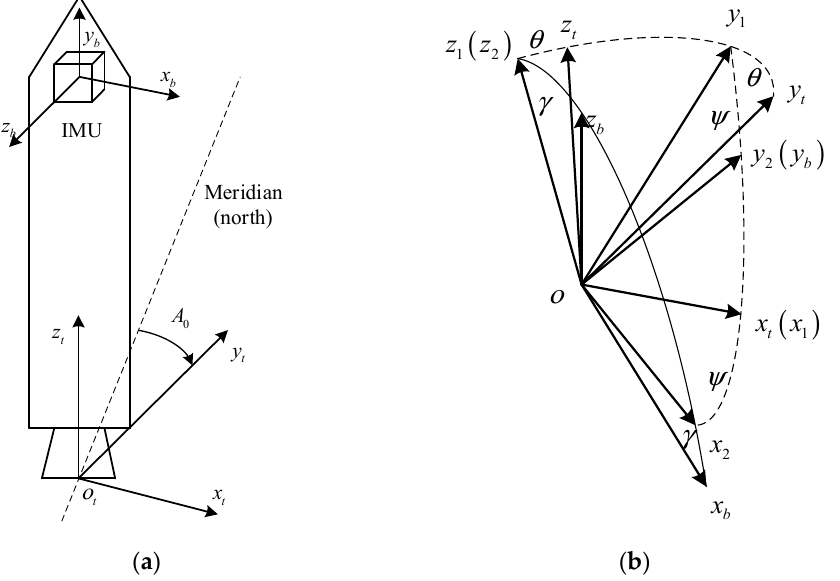
Figure 2. Launch CS and IMU CS of LV [26]. ( a ) Launch CS and IMU CS; ( b ) Euler angle definition. Pitch angle ( θ ): After a coordinate translation so that the origin of the navigation CS coincides with the origin of the IMU CS, the pitch angle is the angle between the projection line of the longitudinal axis ( o b y b -axis) of the LV in the ballistic plane and the o n y n -axis. The angle is positive if the longitudinal axis of the offshore platform points above the horizontal plane; otherwise, it is negative, and the value range is θ ∈ [ 0 ◦ , 180 ◦ ] . Yaw angle ( ψ ): After a coordinate translation so that the origin of the navigation CS coincides with the origin of the IMU CS, the yaw angle is the angle between the longitudinal axis of the LV and the ballistic plane. Looking at the angle plane, if the rotation from the oy n -axis to the oy (cid:48) -axis is counterclockwise, the angle is positive; otherwise, it is negative, b and the value range is ψ ∈ [ − 90 ◦ , 90 ◦ ]